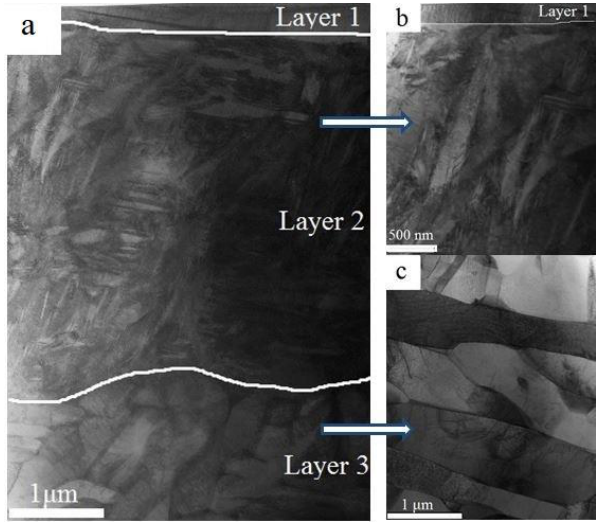
Figure 2. Transmission electron microscopy (TEM) images of the as-built specimen of the EBM Ti-6Al-4V alloy: bright-field image and corresponding microdiffraction ( a ), dark-field image in the (100) α-Ti reflection (indicated by an arrow) ( b ).